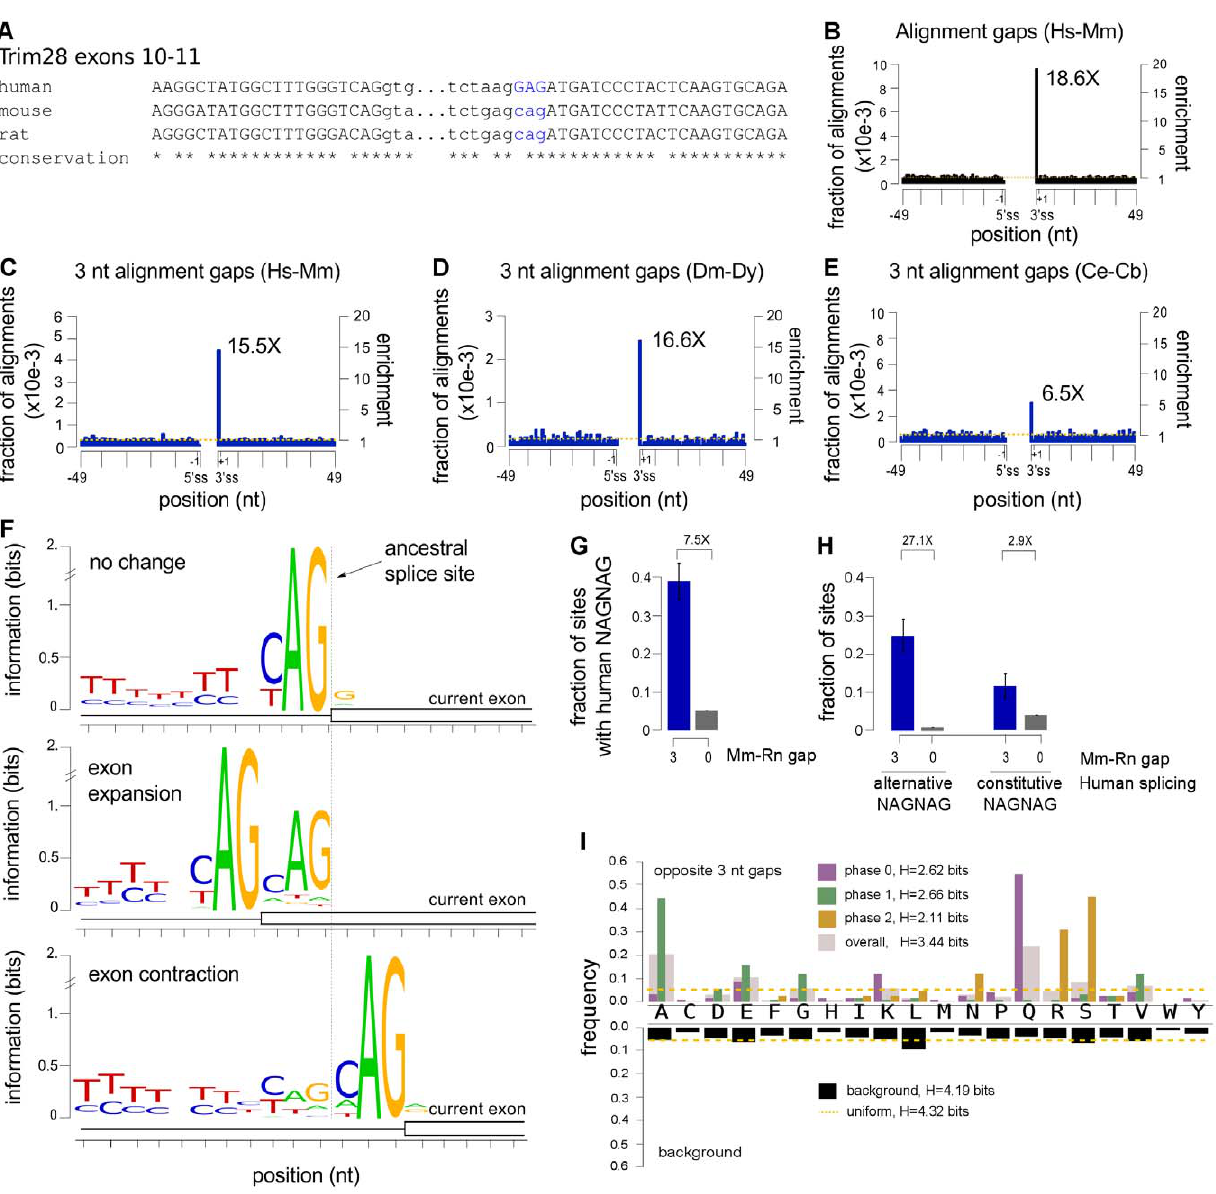
Figure 5. NAGNAGs are associated with accelerated protein evolution at exon-exon boundaries. (A) Alignment of portions of exons 10 and 11 of TRIM28 gene from three mammals, illustrating a shift in the upstream boundary of exon 11 between human and rodents. Exonic sequence shown in capitals; intronic sequence in lower case. (B) Gain/loss of exonic sequence between human and mouse occurs preferentially at 3 9 splice sites ( p , 10 2 6 , permutation test). The fraction of aligned orthologous human and mouse exons with gaps at each position is shown; the background level (mean fraction across the indicated region excluding the 3 9 splice site) is shown by the dotted yellow line; the right-hand axis shows enrichment relative to this background. (C) As in (B), but restricted to gaps of length three bases. Preferential occurrence at 3 9 splice sites was highly significant ( p , 10 2 6 , permutation test). (D) Similar to (C), but based on alignments of orthologous D. melanogaster and D. yakuba exons. Preferential occurrence at 3 9 splice sites was highly significant ( p , 10 2 6 , permutation test). (E) Similar to (C), but based on alignments of orthologous C. elegans and C. briggsae exons. Preferential occurrence at 3 9 splice sites was highly significant ( p , 10 2 6 , permutation test). (F) Residual NAG motif at exons whose boundaries changed in the rodent lineage. Orthologous mouse and rat exons were classified as unchanged (top), expanded by three bases (middle), or contracted by three bases(bottom) based on comparison to an outgroup (human, cow, chicken, or Xenopus laevis ), aligned to the inferred location of the ancestral 3 9 splice site (dotted line). Information content of each position is shown relative to a uniform background composition. (G) Exons whose 3 9 splice site boundaries differ by three bases between rat and mouse are 7.5 times as likely to have a NAGNAG in the human ortholog as exons whose boundaries did not change ( p -value for difference , 10 2 24 by Fisher’s exact test). Error bars indicate the 95% binomial confidence interval. (H) Rodent exons orthologous to alternatively spliced human NAGNAG exons (left) are much more likely to exhibit exon boundary changes of three base pairs than those orthologous to constitutively spliced human NAGNAGs (right) ( p -value for difference , 10 2 10 by Fisher’s exact test). Blue and gray bars in (H) represent subsets of blue and gray bars in (G), respectively. Error bars indicate the 95% binomial confidence interval. (I) Frequency of encoded amino acids that occur opposite gaps at the 3 9 splice site in alignments of human and mouse exons is plotted above, overall (pink) and separately by the phase of the upstream intron (i.e., the number of bases, if any, in the last incomplete codon of the upstream exon); amino acid frequency at background positions (4 codons downstream of the 3 9 splice site) is shown below. The Shannon entropy (a measure of randomness) of each amino acid frequency distribution is also shown. doi:10.1371/journal.pbio.1001229.g005 PLoS Biology |